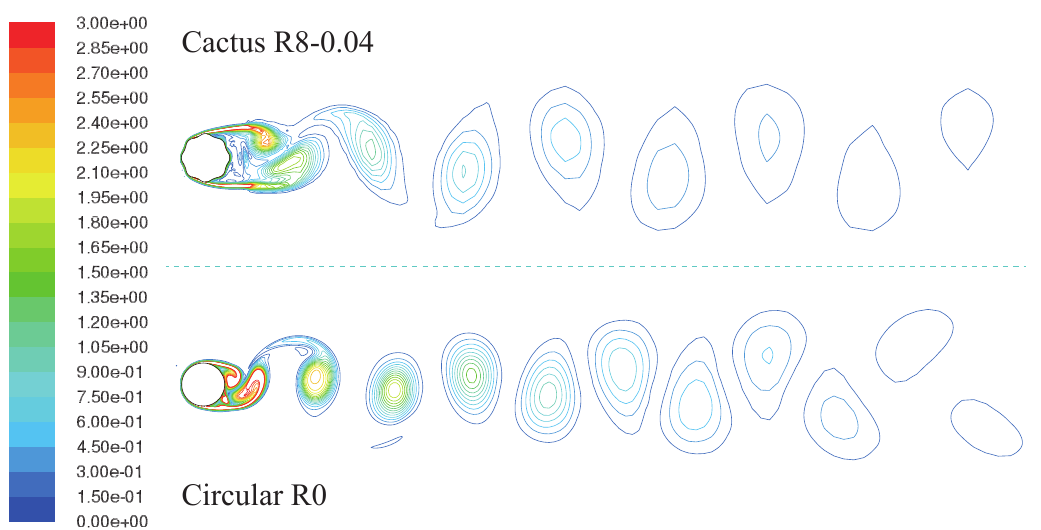
Figure 6. Contours of the current vorticity magnitudes around a single stationary cylinder at the Reynolds number of Re = 3900: a circular cross-section, R 0 ( lower ), and a cactus-shaped cross section, R 8-0.04 ( upper ).